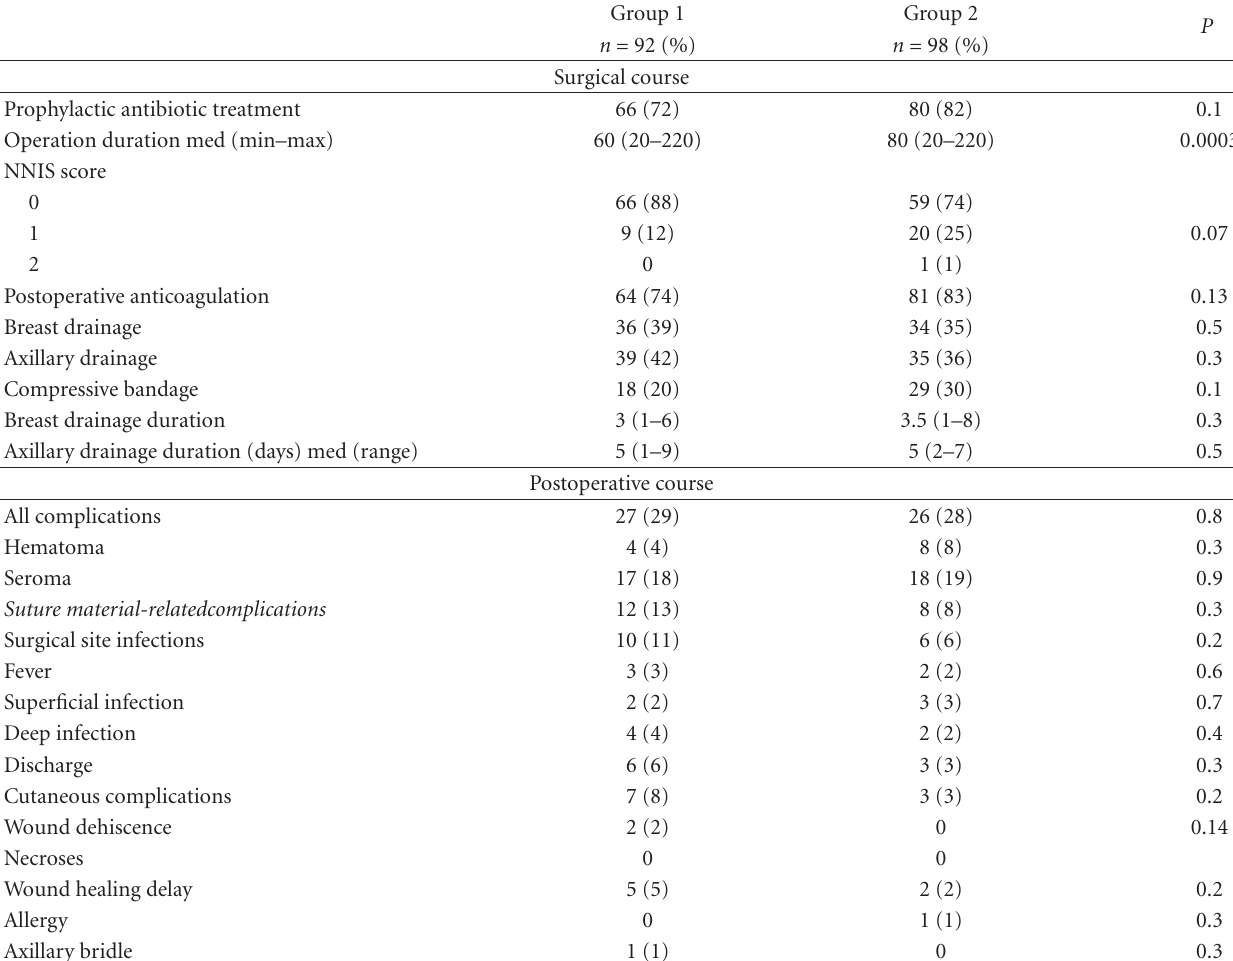
Table 2: Surgical and postoperative